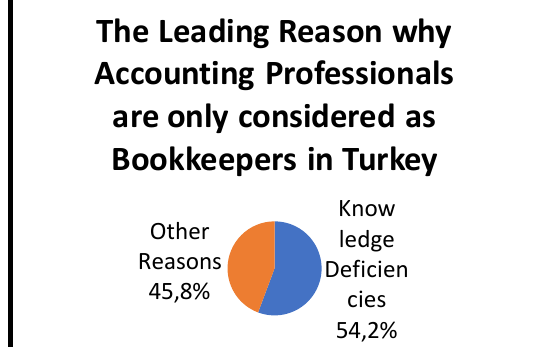
Figure 5. The Leading Reason why Accounting Professionals are only considered as Bookkeepers